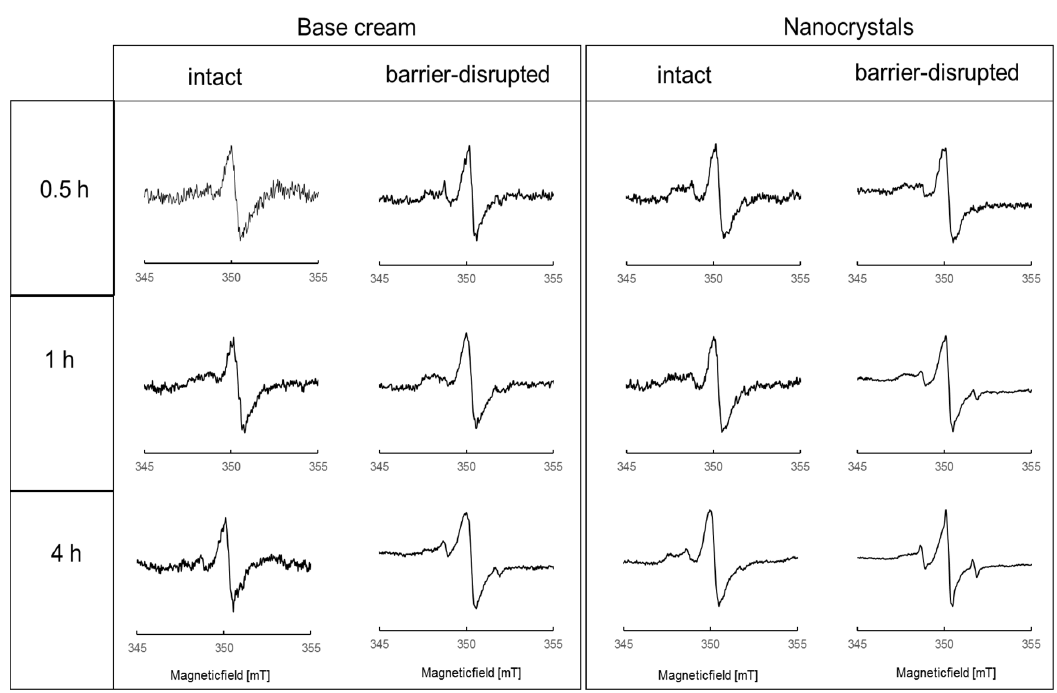
Figure 4. Normalized X-Band EPR spectra of spin-labeled Dx within the viable epidermis after the topical application of a base cream formulation (left column) and nanocrystals (right column) to intact and barrier-disrupted skin and penetration times of 0.5, 1.0, and 4.0 h.